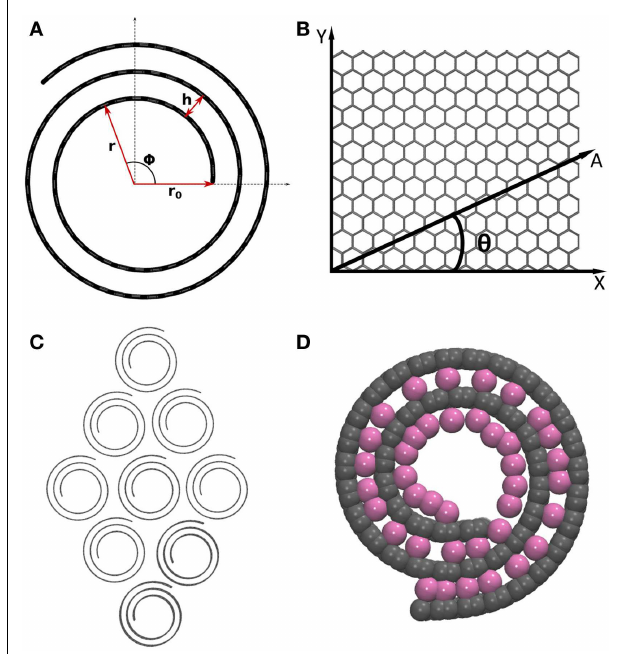
FIGURE 2 | (A) Scheme showing the CNS cross-section. See Eq. 1 and Section “Structure” for the definition and the relationship between r 0 , h , r , and φ . (B) Scheme for rolling up a CNS from a graphene sheet. θ is the rolling angle and A is the CNS axis. (C) Nanoscroll bundle. (D) Cross-section view of an intercalated nanoscroll. See text for